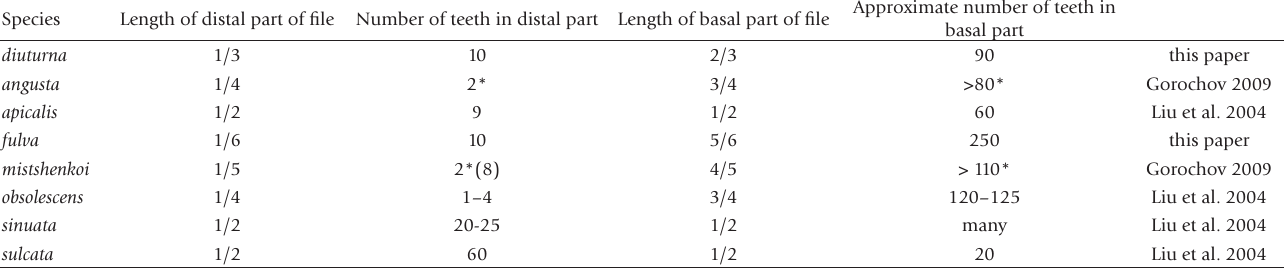
Table 1. Proportions of distal and basal part and number of teeth in stridulatory file in Ectadia species. Species Length of distal part of file Number of teeth in distal part Length of basal part of file